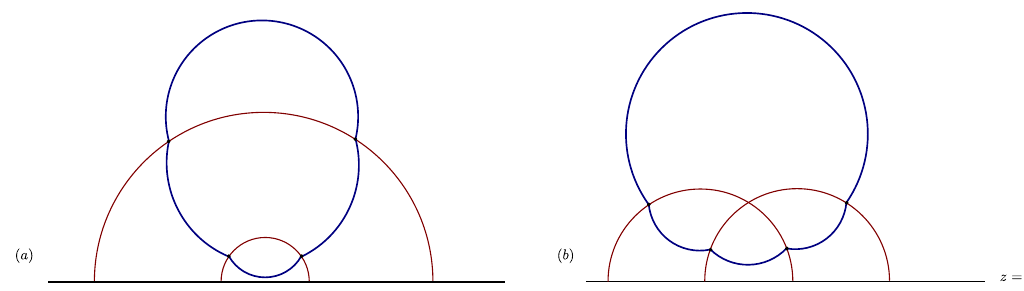
Figure 19 . Four-point function for ( a ) time-ordered and ( b ) out of time ordered